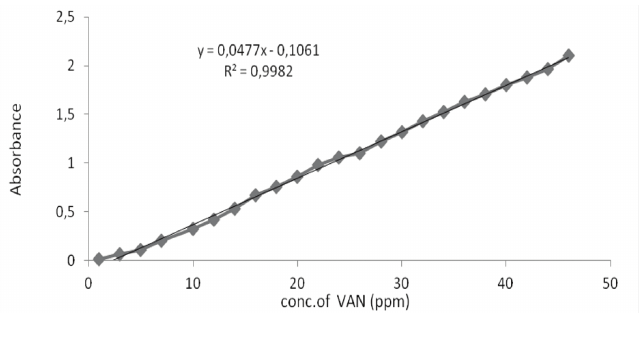
Figure 2 - Calibration curve of VAN